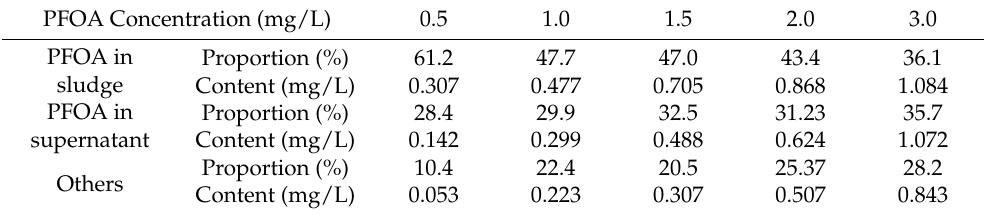
Figure 4. PFOA content in sludge and supernatant of each reactor and the removal rate of PFOA by the AD reaction system. Table 2. The proportion and content of PFOA in supernatant and sludge in each